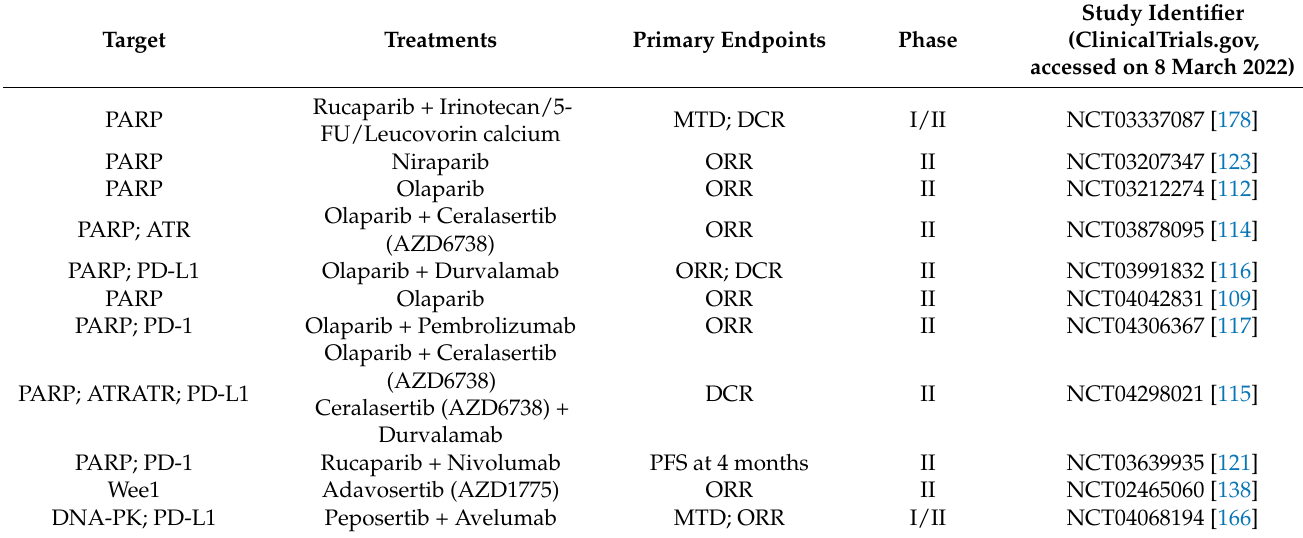
Table 1. Active clinical studies of DDR inhibitors in CCA